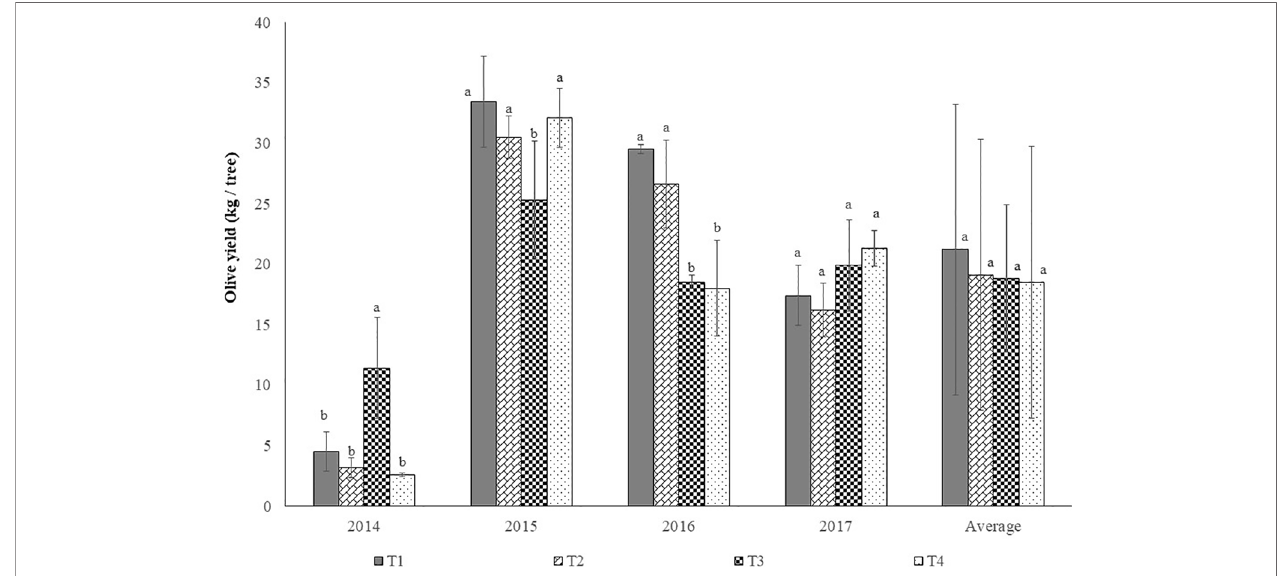
FIGURE 11 | Olive yield by treatment in each year and the average yield of the trial (mean±sd). Legend: T1, treatment 1; T2, treatment 2; T3, treatment 3; T4, treatment 4. In each year and in average, columns followed by the same letter are not signi fi cantly different by Duncan multiple range test at the 5% level, with the exception of 2015, where p < 0.1.